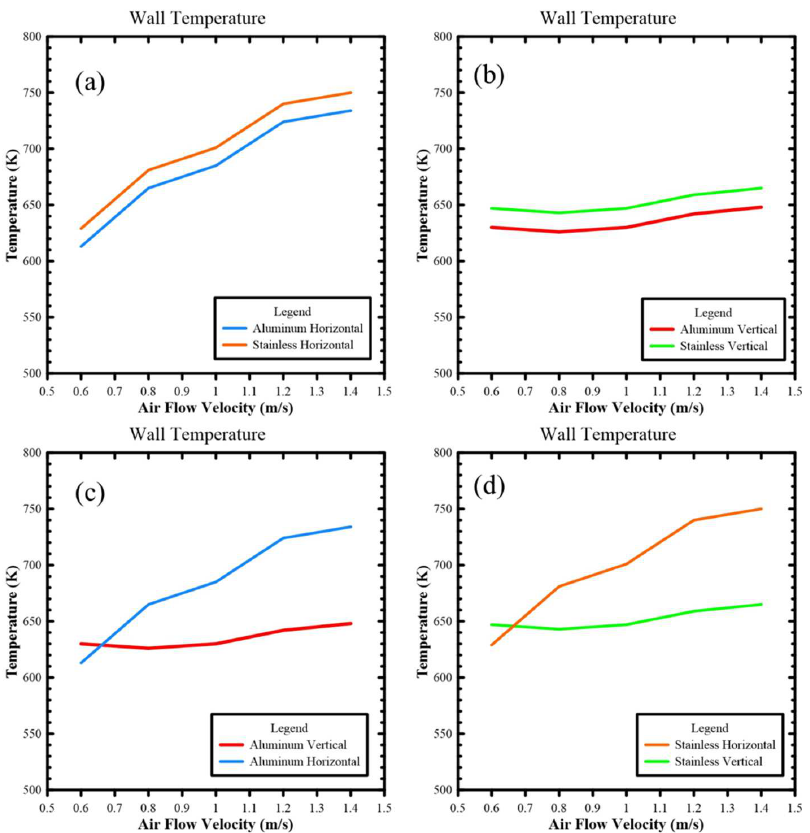
Figure 14. Wall temperatures from numerical simulation for ( a ) horizontal combustor, ( b ) vertical combustor, ( c ) aluminum material, and ( d ) stainless material .